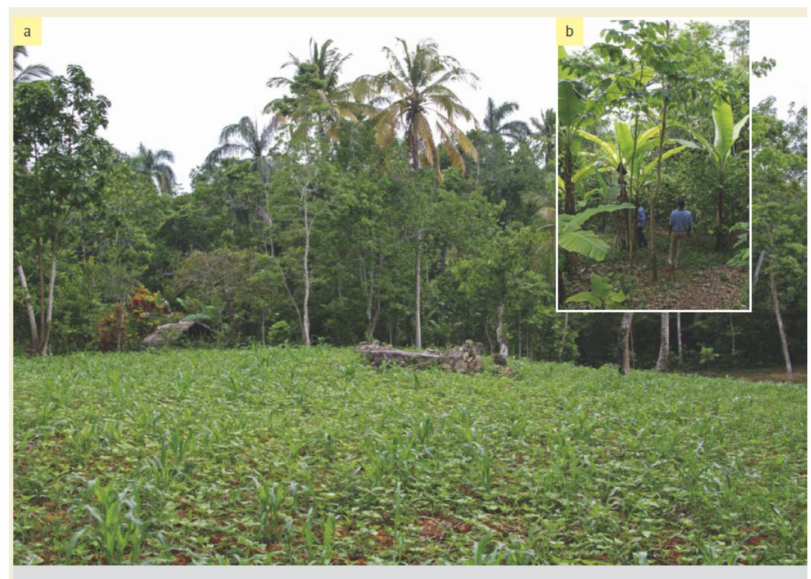
Figure 1. ( a ) On the foreground is an open garden contrasting with a lakou garden in the background. ( b ) Internal view of a lakou [garden] with its different strata. Photo P. Fernandes (reproduced with permission from Jean-Denis et al. [40], copyright P Fernandes, Cirad, 2014).